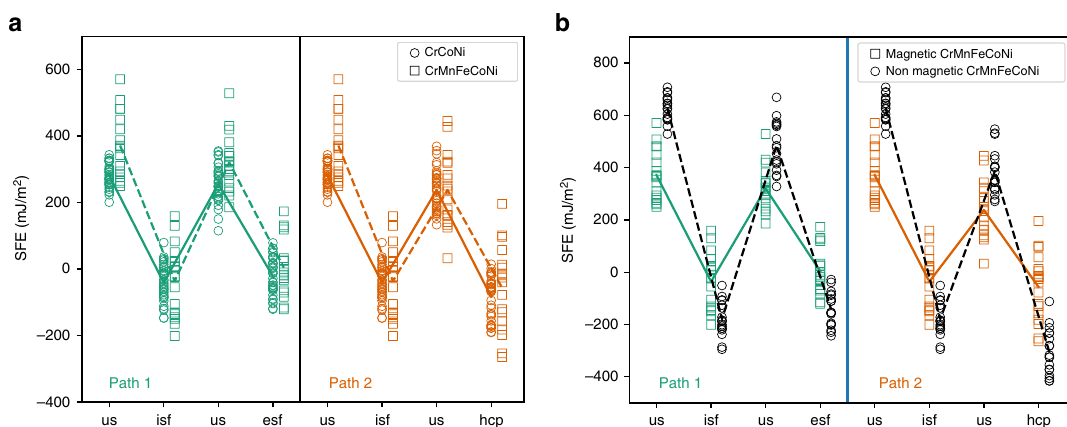
Fig. 6 Planar fault energies in CrMnFeCoNi. a The fault energies with those of the ternary CrCoNi. The values in the ternary alloy are the same as those presented in path and are repeated here for easy comparison. Paths 1 and 2 correspond to the formation of extrinsic stacking faults versus hcp laths, as de fi ned in Fig. 5. b The effect of magnetism on fault energies in the quinary alloy. The average behavior of both alloys follow similar trends, however, the scatter relative to the average behavior is much more signi fi cant in the quinary alloy. Note several overlaps between energies of the stable and unstable structures in the quinary alloy. Nonmagnetic calculations show much smaller scatter in energies, although variations are still expected due to the changing chemical environment. The overlap between stable and unstable nonmagnetic energy values is eliminated, with consistently favorable hcp energies